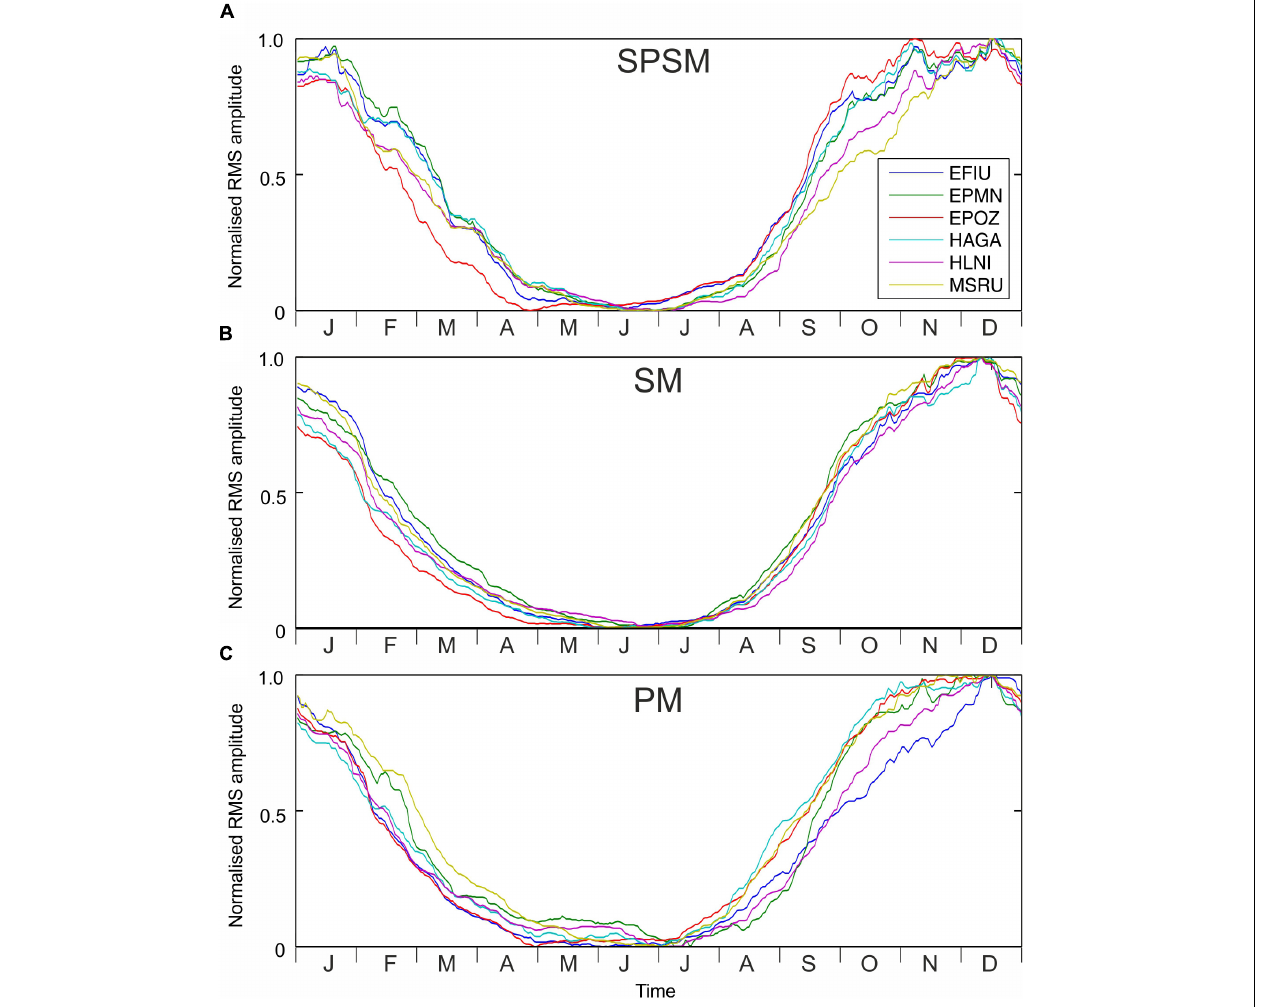
FIGURE 5 | RMS amplitude time series smoothed by a 90-day-long moving median, split into 1-year-long windows, stacked, and normalized for all the considered seismic stations (see the legends on the bottom right corner of (A) . In particular, regarding the period bands (A) 2.5–5 s (SPSM), (B) 5–10 s (SM), and (C) 13–20 s (PM). The time on the x -axis of (A–C) indicates the window onset of the 90-day-long moving median.